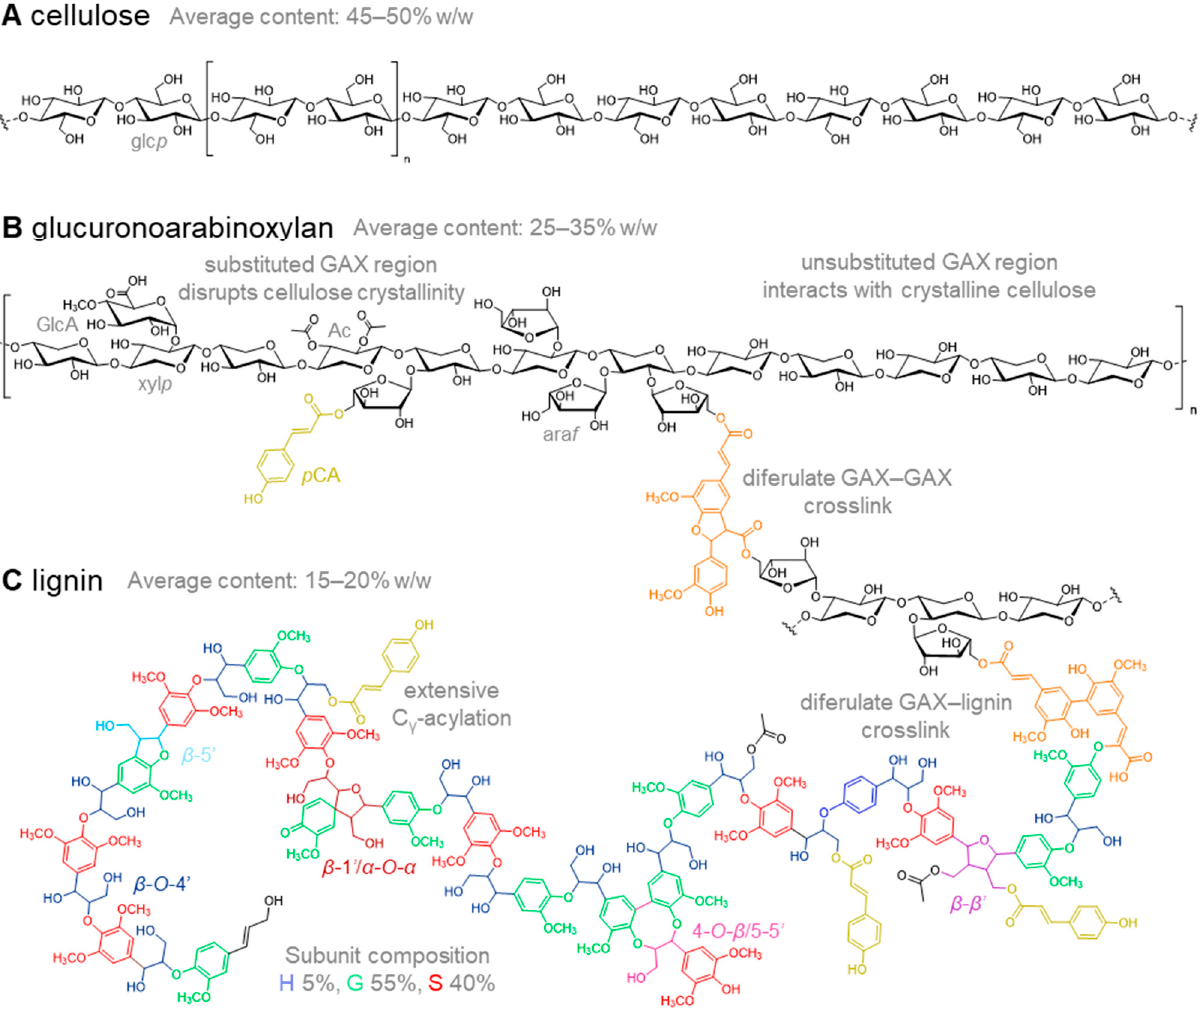
Figure 1. Schematic representation of the major constituents of the miscanthus secondary cell wall. The cellulose ( A ), glucuronoarabinoxylan (GAX) ( B ) and lignin ( C ) structures attempt to fairly represent the (relative) abundances of each individual structural moiety and the interactions between the polymers based on literature. Note that for simplicity only two types of diferulates (8-5 and 5-5) are shown, though many other linkage types are known to exist.